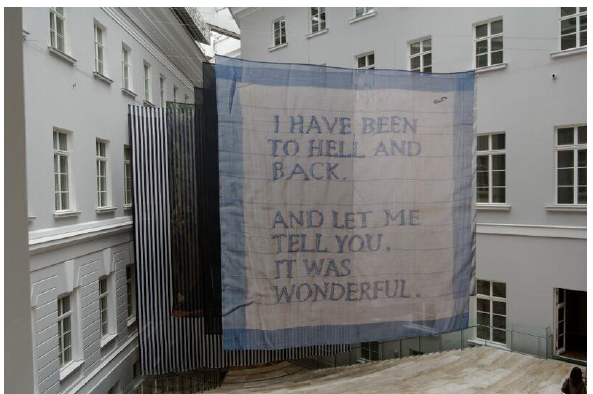
Figure 5 | Dominique Gonzalez-Foerster, The Handkerchief’s Opera (2014). Mixed media. Courtesy the artist. Commissioned by MANIFESTA 10, St. Petersburg.